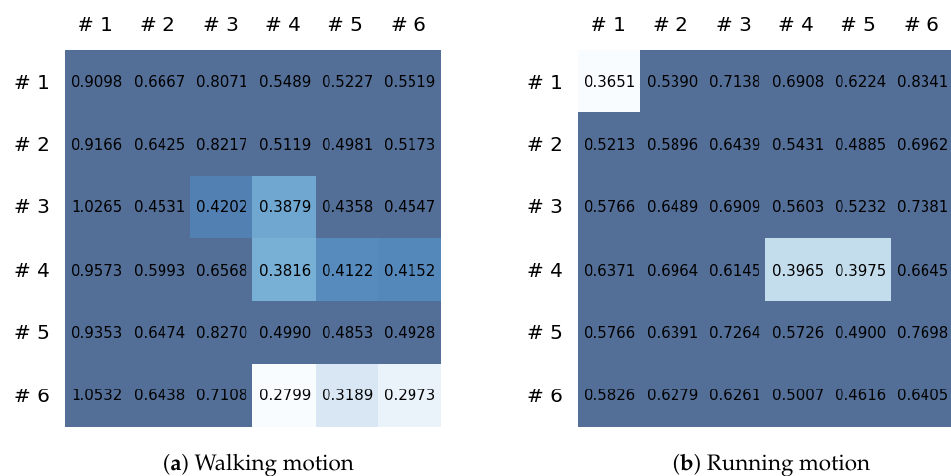
Figure 18. MSE values of the FNO model using CRP for each subject for running motion.